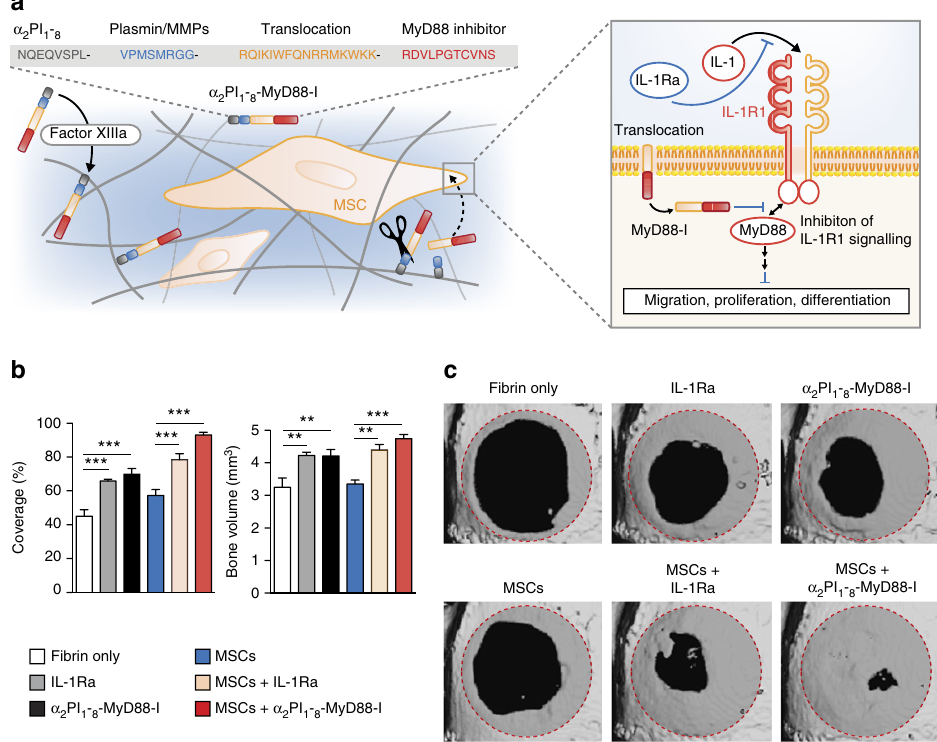
Figure 7 | Inhibition of IL-1R1/MyD88 signalling promotes MSC-driven bone regeneration. ( a ) Design of the MyD88 inhibitor peptide ( a 2 PI 1-8 -MyD88-I). A fibrin-binding sequence derived from a 2 -PI 1-8 (NQEQVSPL, in grey) is followed by a plasmin/matrix metalloproteinase-sensitive sequence (VPMSMRGG, in blue), a membrane translocation sequence (RQIKIWFQNRRMKWKK, in orange) and the MyD88 inhibitor peptide (RDVLPGTCVNS, in red). The peptide is covalently crosslinked into fibrin fibres (in grey) during the natural polymerization process of the matrix via the transglutaminase activity of factor XIIIa. Then, following matrix remodeling, the peptide is released by proteases (represented as scissors), translocates into cells, and ultimately inhibits IL-1R1/MyD88 signalling. ( b , c ) Critical size calvarial defects (5mm diameter) in mice were treated with or without MSCs delivered by a fibrin matrix. Fibrin matrices were functionalized with IL-1Ra (1 m g) or a 2 PI 1-8 -MyD88-I (4 m g). Eight weeks after treatment, bone regeneration was measured by microCTas coverage of the defect and bone volume. Data are means ± s.e.m. ( n ¼ 6 per condition). ANOVA with Bonferroni post hoc test for pair-wise comparisons; ** P o 0.01, *** P o 0.001. Representative calvarial reconstructions are shown in c . Original defect area is shaded with a red dotted outline. ANOVA, analysis of